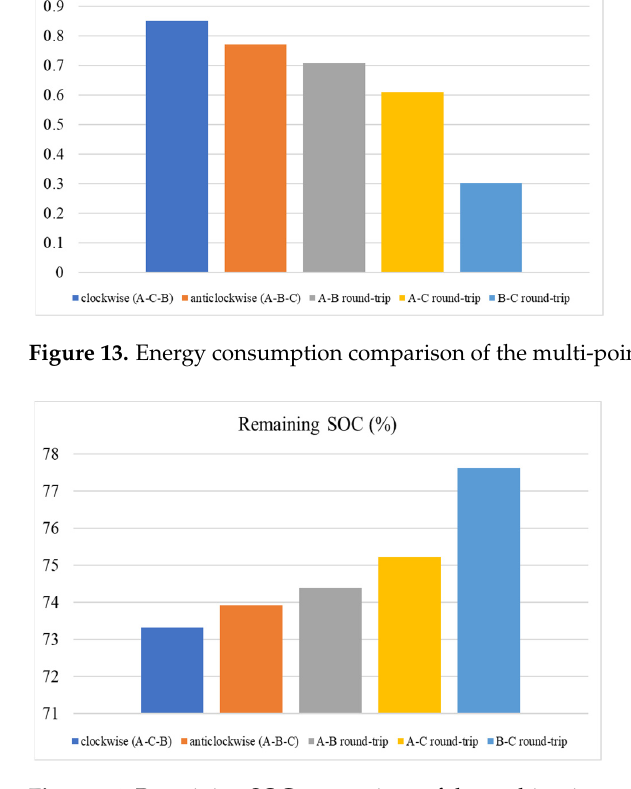
Figure 14. Remaining SOC comparison of the multi-point routes.